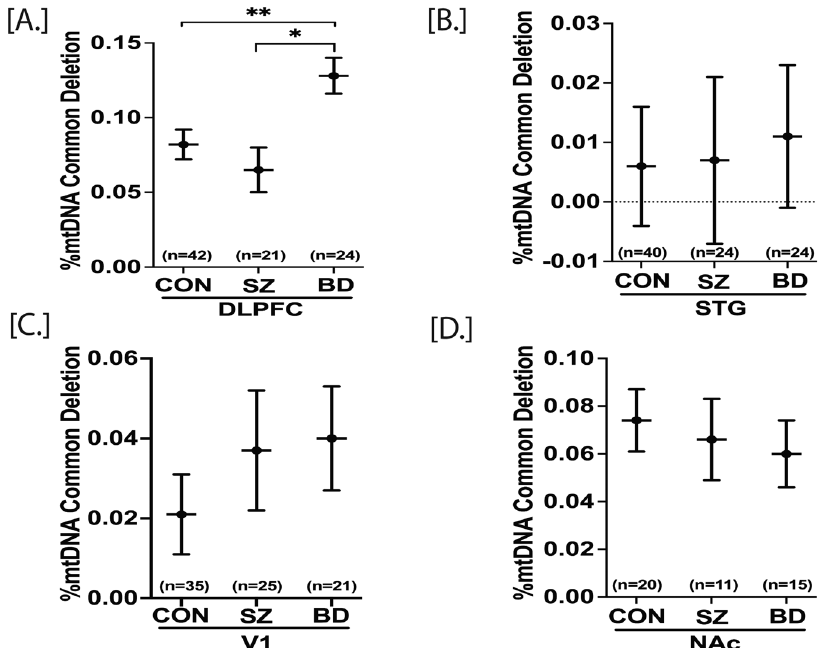
Fig. 2 mtDNA common deletions in postmortem DLPFC, STG, V1 and NAc of control (CON), schizophrenia (SZ) and bipolar disorder (BD) groups. mtDNA common deletion (CD) for DLPFC, STG and NAc were obtained through qPCR while V1 mtDNA copy number was obtained through ddPCR. %mtDNA CD was calculated as [mtDNA CD copies/ (wild type mtDNA copies + mtDNA CD copies)] x 100. A repeated measure analysis was performed for statistical signi fi cance with adjustment of age and sex for the DLPFC and STG. The V1 and NAc were analyzed separately. DLPFC mtDNA CD was signi fi cantly higher in BD compared to control group ( A ). There were no signi fi cant group differences in STG, V1 and NAc mtDNA CD ( B – D ). All data are represented as least square mean (LSM) ± Std. error. p < 0.05 and p < 0.01 are denoted by * and **, respectively, otherwise p > deletion metrics as previously described [30]. Here, we focused on the cumulative analysis of “ deletions per 10K coverage ” , which is the estimation of the pooled effect of total deletions species (i.e., unique set of breakpoints), as the other two metrics described in our method [30] were not signi fi cantly different in group comparisons. Previously, we showed that deletions per 10K coverage parameter did not signi fi cantly vary with age, brain pH and postmortem interval (PMI) [30]. Here, we computed standar- dized residuals for deletions per 10K coverage with benchmark coverage and age added as a covariate. The repeated measure analysis revealed that the standardized residuals of deletions per 10K were signi fi cantly higher in DLPFC of both SZ ( p = 0.036) and BD ( p = 0.000055) compared to CON (Fig. 3A). There were no other signi fi cant group comparisons within STG [CON vs SZ, p = 0.78;